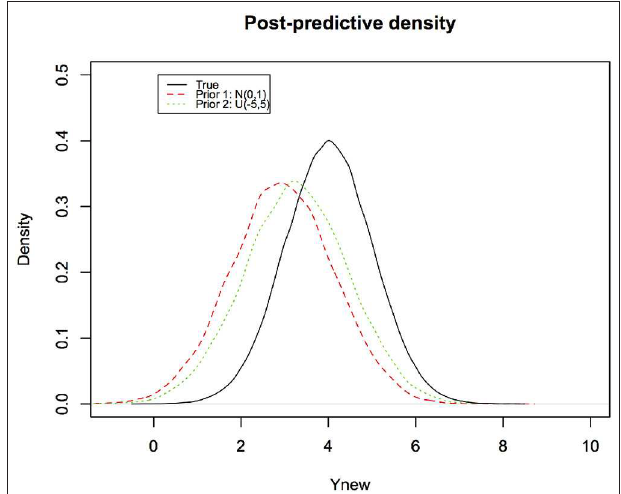
FIGURE 6 | Bayesian predictive densities representing the post-data belief about the observation to be predicted. Notice how the effect of different priors has been reduced by the data. They are much closer to the true density (black